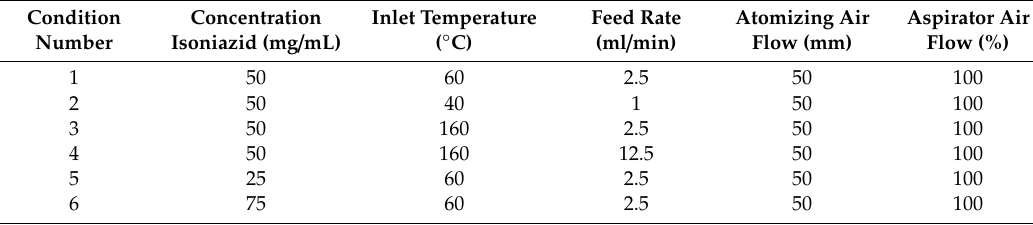
Table 1. Spray drying conditions used with the B-290 mini spray dryer. N =